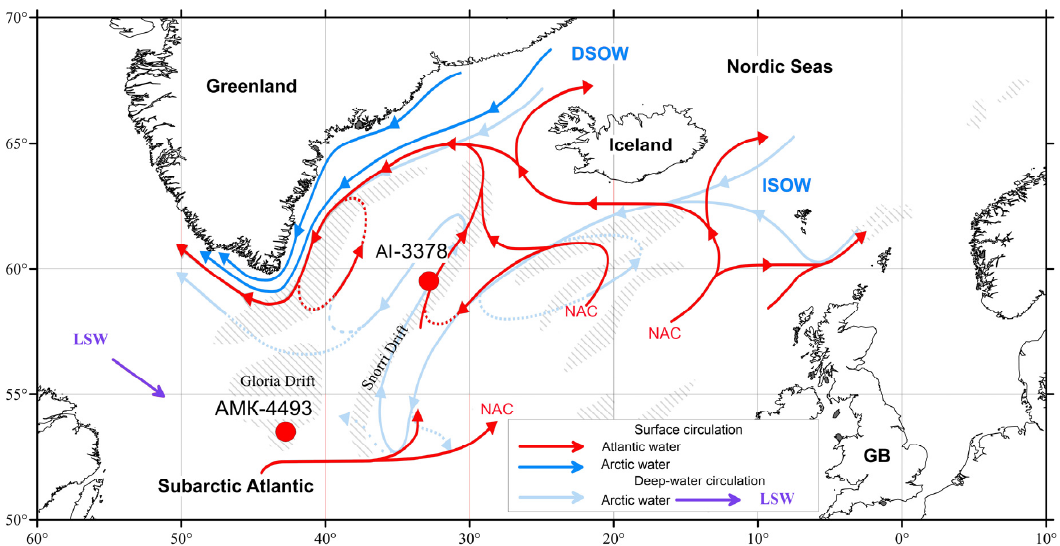
Figure 1. Location of sediment sampling stations at the Snorri Drift (AI-3378) and Gloria Drift (AMK-4493) and main surface and deep currents responsible for water exchange between the Atlantic Ocean and Arctic Basin [32]. NAC, North Atlantic Current; IC, Irminger current; EGC, East-Greenland Current; DWBC, Deep Western Boundary Current; DSOW, Denmark Strait Overflow Water; ISOW, Iceland-Scotland Overflow Water; LSW, Labrador Sea Water. Dash shows the position of Gloria and Snorri Drifts.